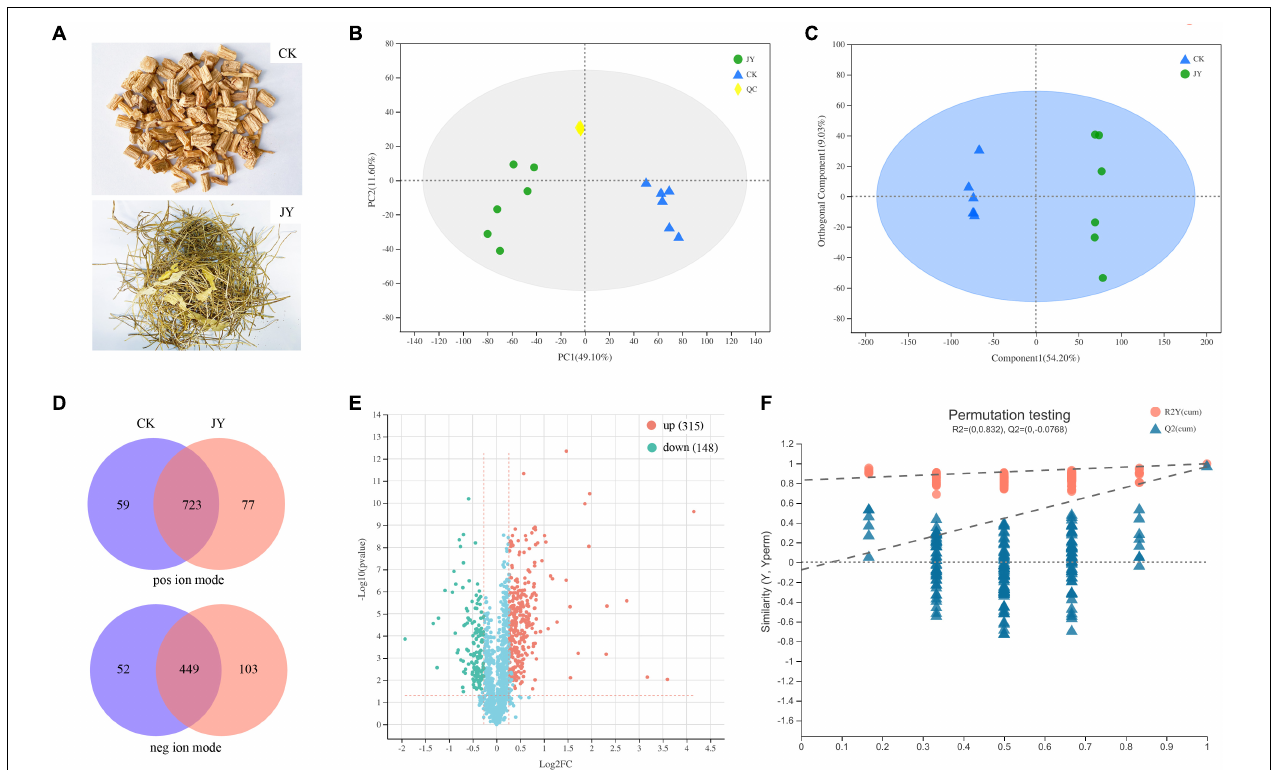
FIGURE 1 | Overview of metabolomics in Codonopsis pilosula . Samples (A) , principal component analysis (PCA) (B) , orthogonal partial least squares discriminate analysis (OPLS-DA) (C) , score plots Venn diagram (D) , volcano plot (E) and OPLS-DA model permutation test (F) of metabolites for comparison between JY and CK